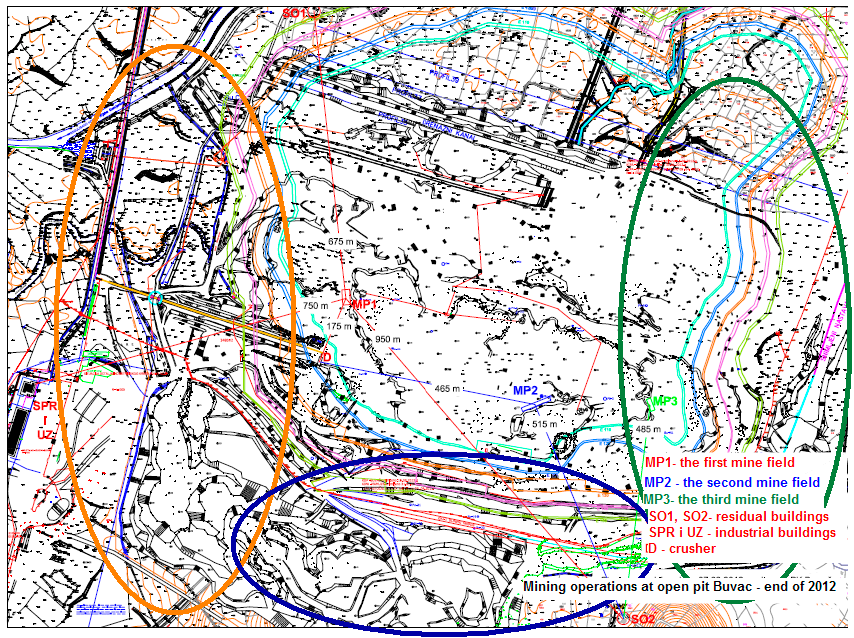
Figure 2. Graphical display of the objects’ positions and the potentially closest minefield.